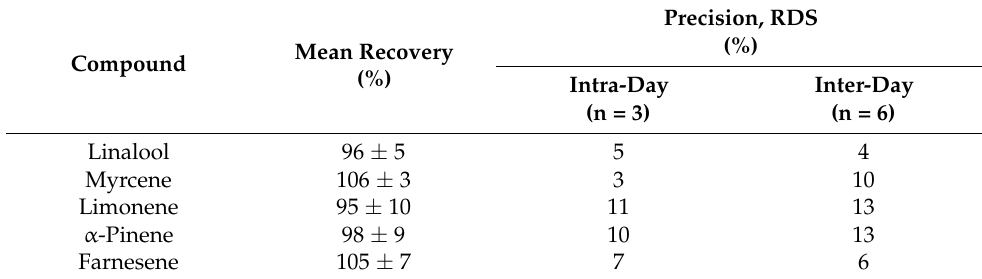
Table 3. Recovery and precision obtained in spiked green coffee. Values calculated for a spiked amount of the analytes of 0.25 mg g − 1 . Compound